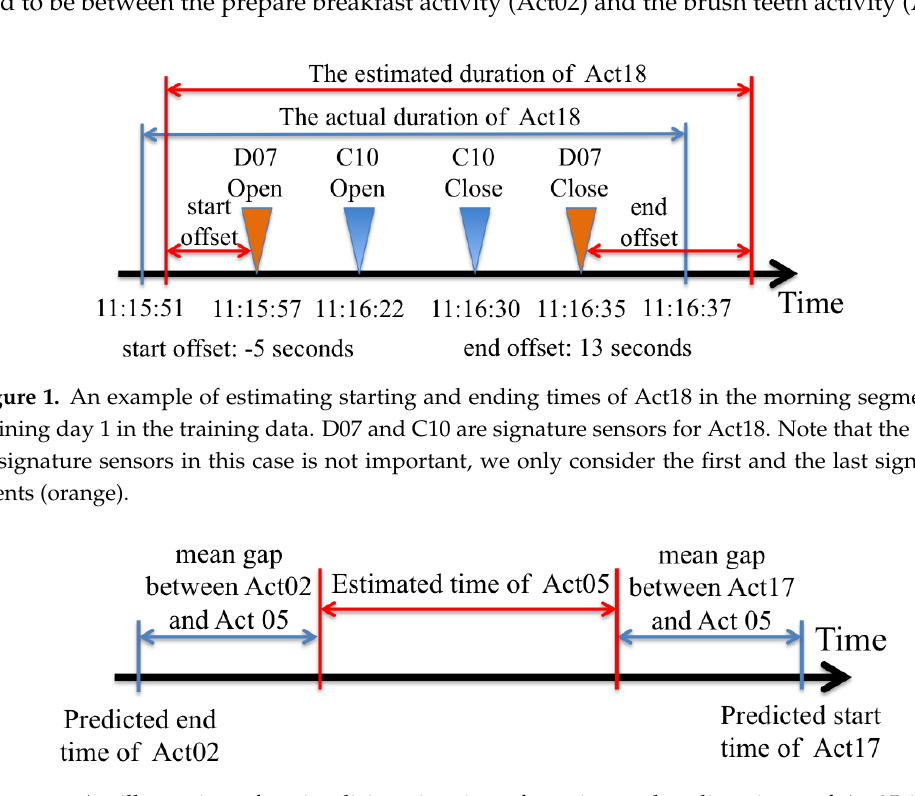
Figure 2. An illustration of an implicit estimation of starting and ending times of Act05 in the morning